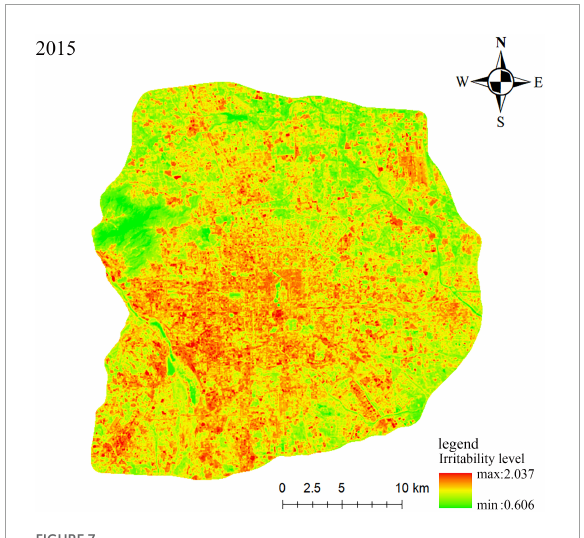
FIGURE7 Risk pattern of irritability in the Sixth Ring Road in 2015.